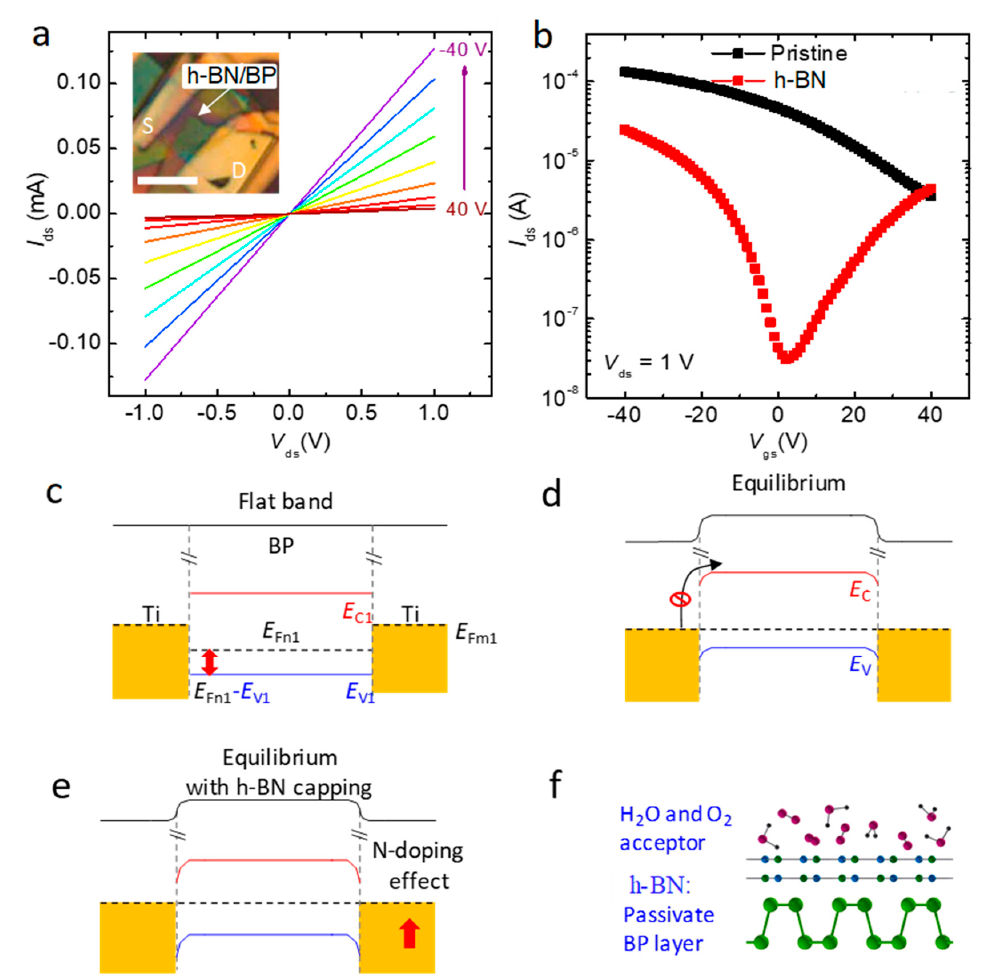
Figure 2. Electrical characteristics of h-BN-capped BP FET devices and mechanisms underlying the formation of ambipolar BP. ( a ) Output curves obtained from h-BN-capped devices, as a function of the gate bias. The inset shows an OM image of the device. The scale bar indicates 5 µm. ( b ) Transfer curves obtained from the pristine and h-BN-capped BP devices. ( c , d ) A band diagram of the pristine BP FET under flat band and equilibrium state. ( e ) The equilibrium state of the band diagram for h-BN-capped devices. ( f ) Schematic diagram describing the n-doping function of the h-BN capping layer on the BP layer. The h-BN protected the BP from acceptor adsorbates, such as water or oxygen, present in the ambient air.